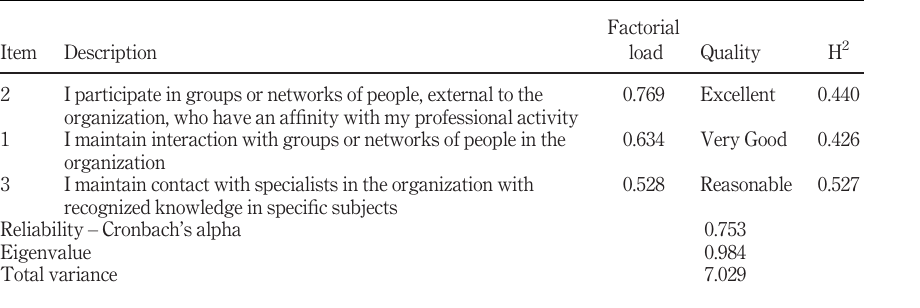
Table VII. Synthesis of